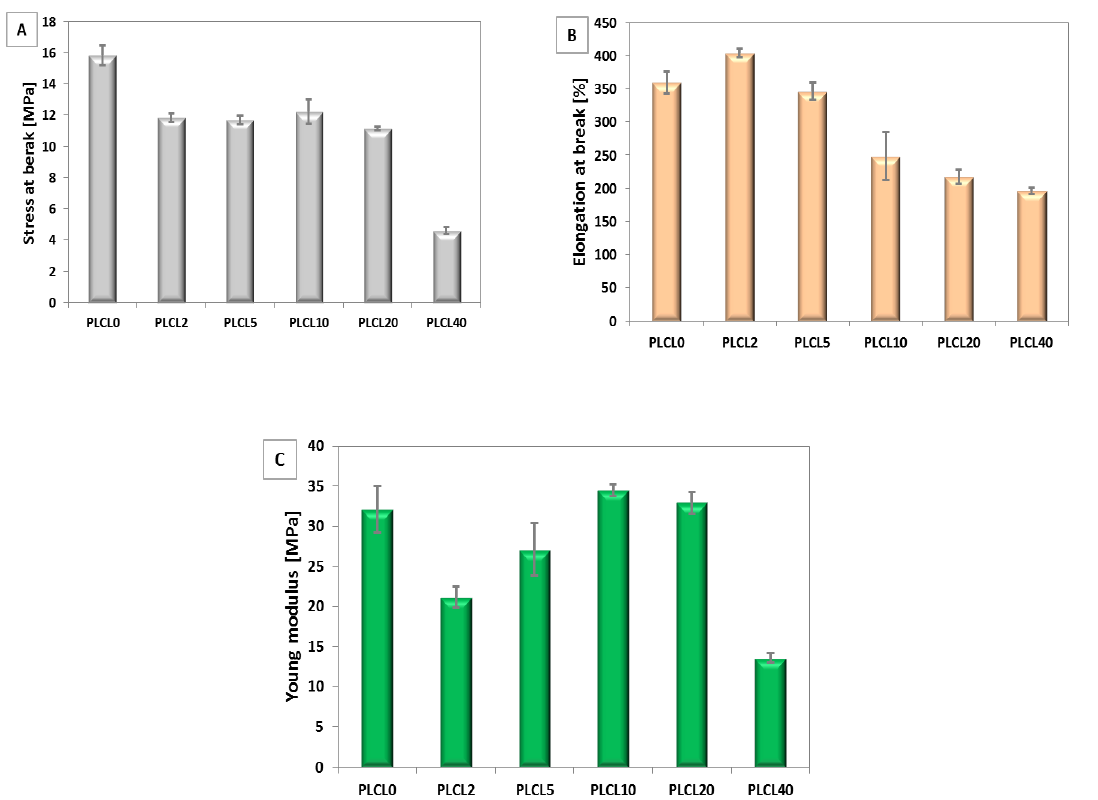
Figure 9. Mechanical properties of bicomponent fibres with additive PGSu to PLCL: ( A ) stress at break, ( B ) elongation at break, and ( C ) Young’s modulus.